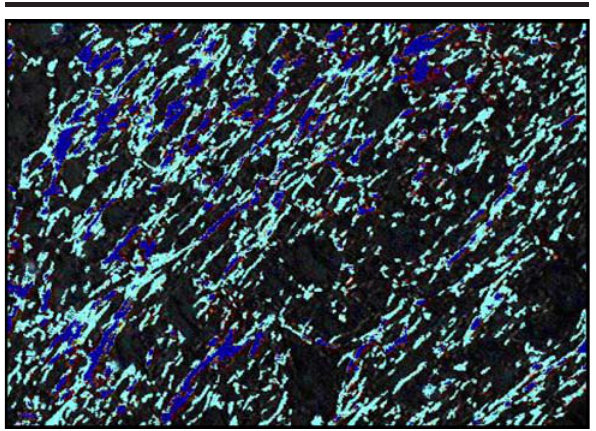
FIGURE 1 - Histologic photomicrography showing collagen densitometry with predominance of immature collagen (green shades) in experiment group